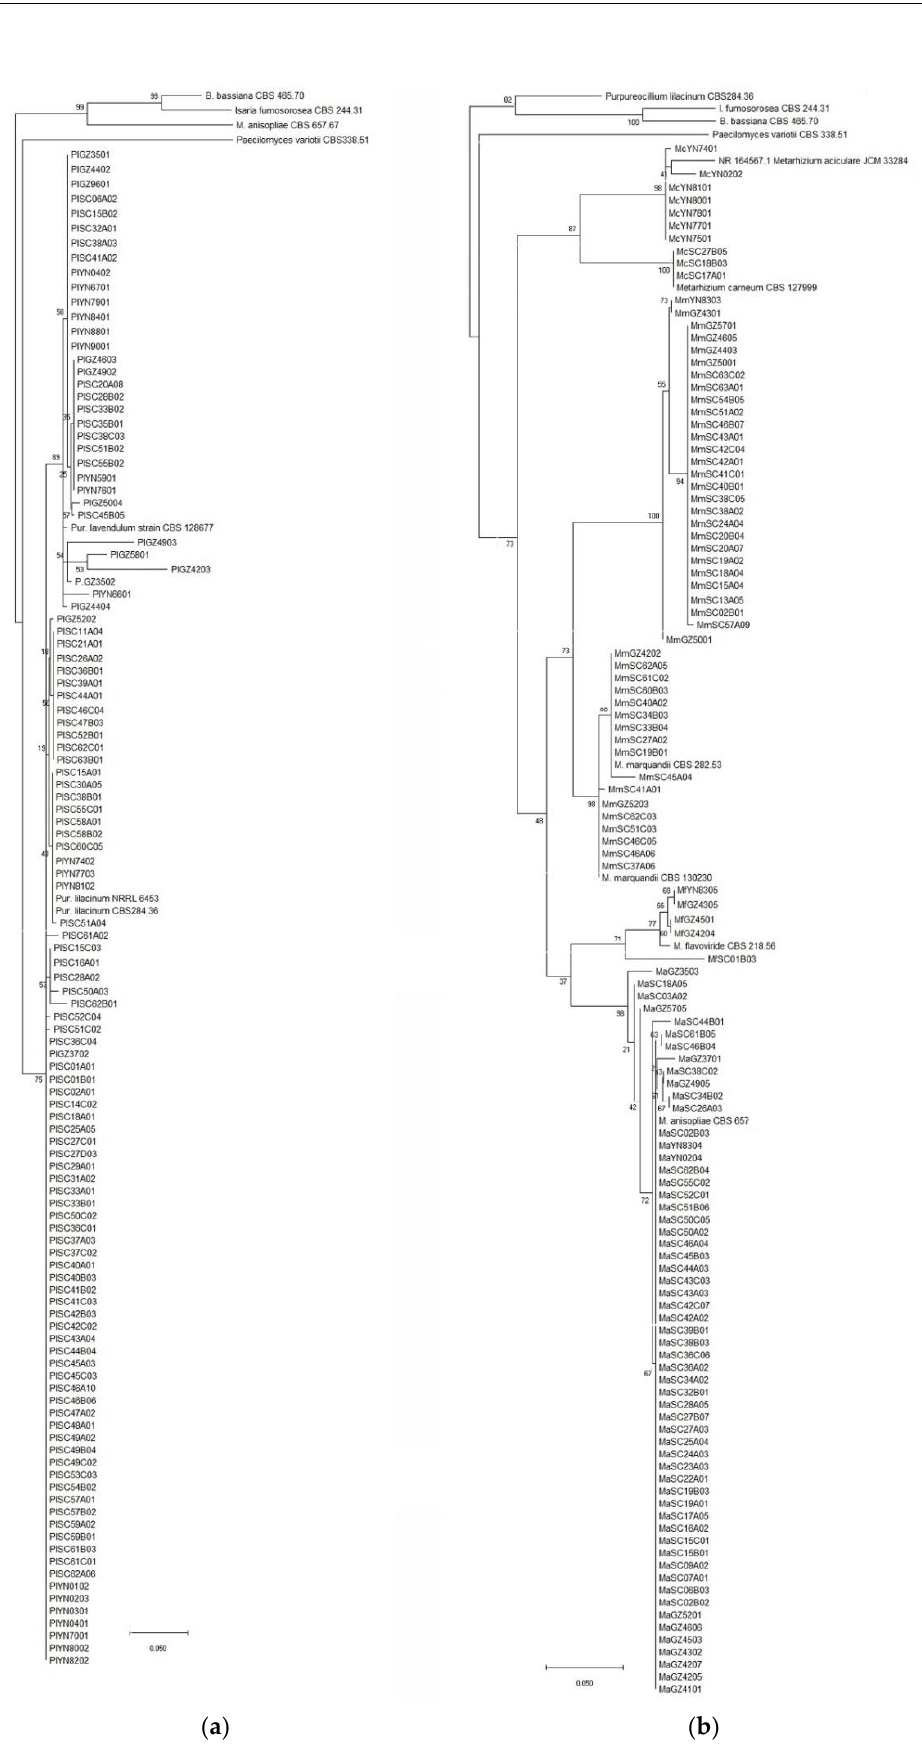
Figure 2. ( a ) Phylogenetic tree of Purpureocillium spp.; ( b ) Phylogenetic tree of Metarhizium spp.